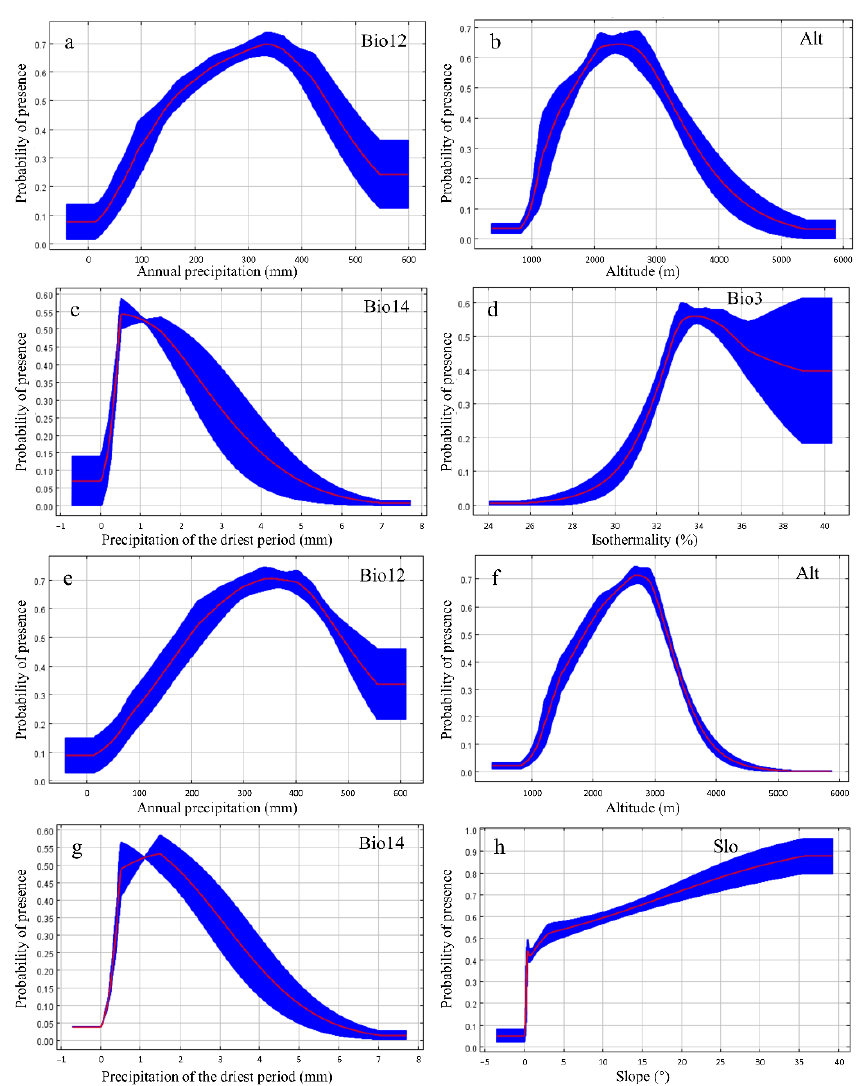
Figure 2. Response curves for the first four important environmental predictors in the species distribution model for G. chilianensis ( a – d ) and T. hsutschouensis ( e – h ) under the current climate scenario. The curves show how the predicted probability of presence changes as each environmental variable is varied, keeping all other environmental variables at their average sample value. The red and blue lines indicate the mean response of the 10 replicate Maxent runs and the mean +/ − one standard deviation, respectively.